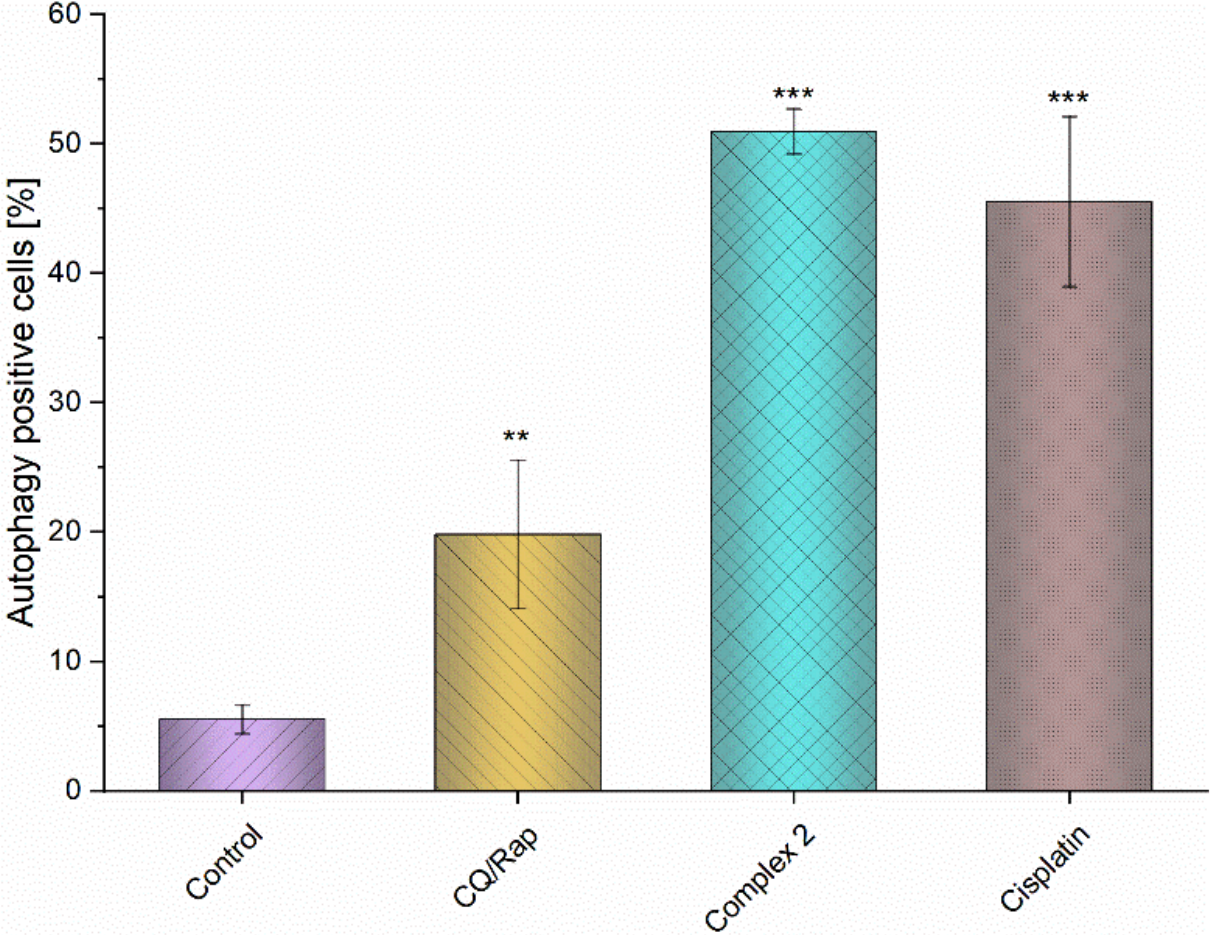
Figure 10. The induction of autophagy in the A2780 cells caused by complex 2 (3 µ M), reference drug cisplatin (19 µ M), and the mixture of chloroquine and rapamycin, a moderate inductor of autophagy after 24 h of incubation. The significant change in the number of cells showing the signs of autophagy caused by the corresponding compound compared to the untreated control is symbolized by ** at the p ≤ 0.01 level, and *** at the p ≤ 0.005